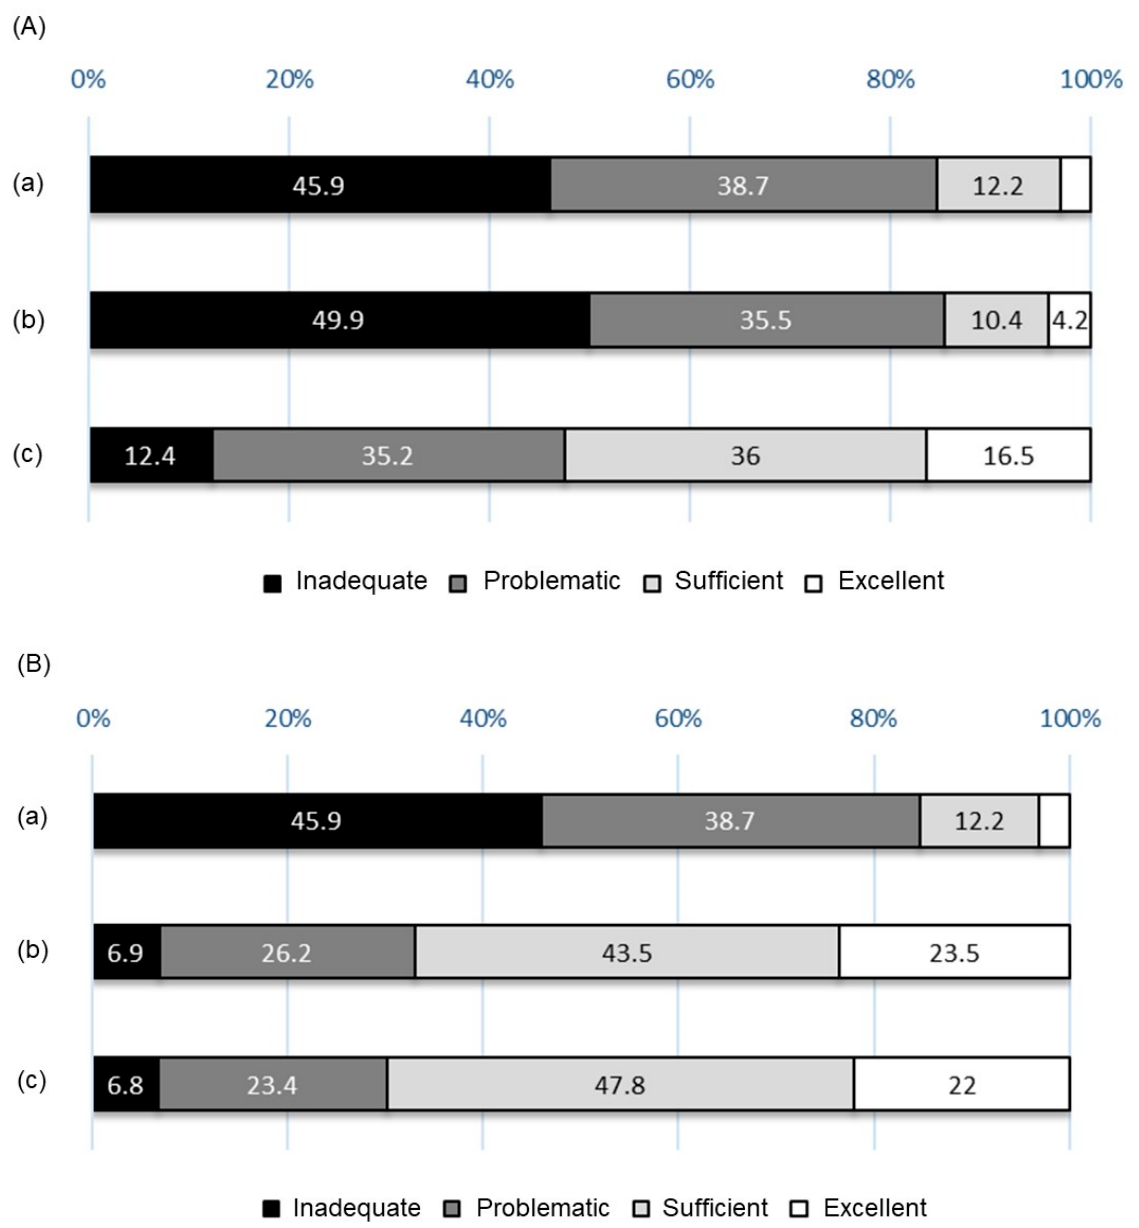
Figure 5. ( A ) Comparison with previous reports on HL levels. ( a ) The results of this study; ( b )